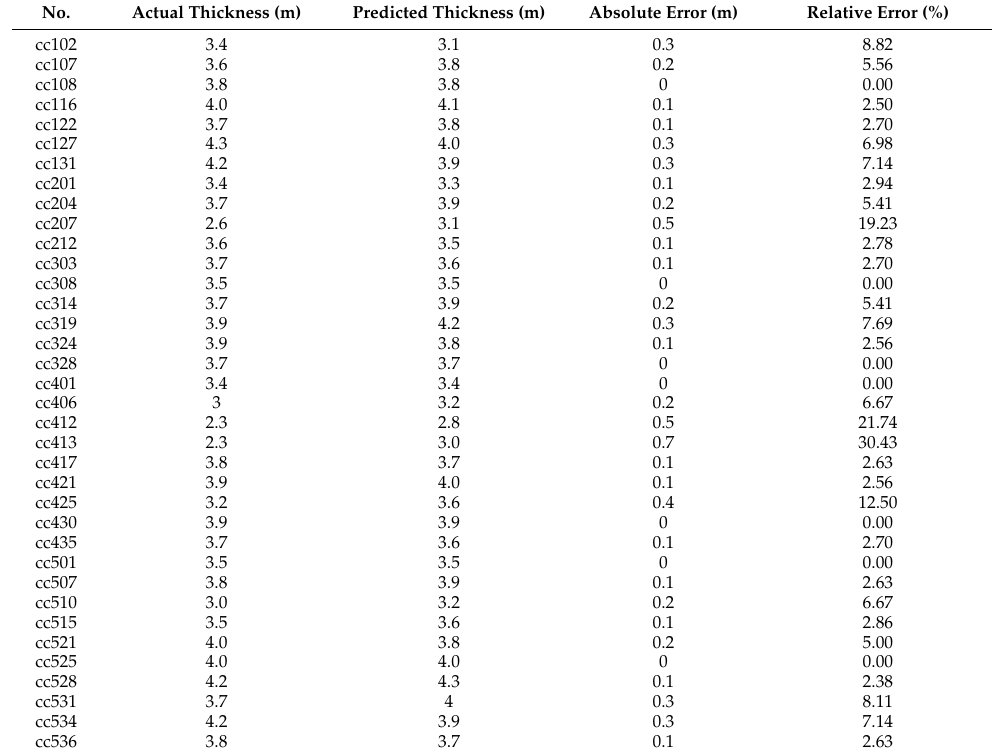
Table 4. Comparison of coal thickness prediction results of typical sampling points in the secondary mining